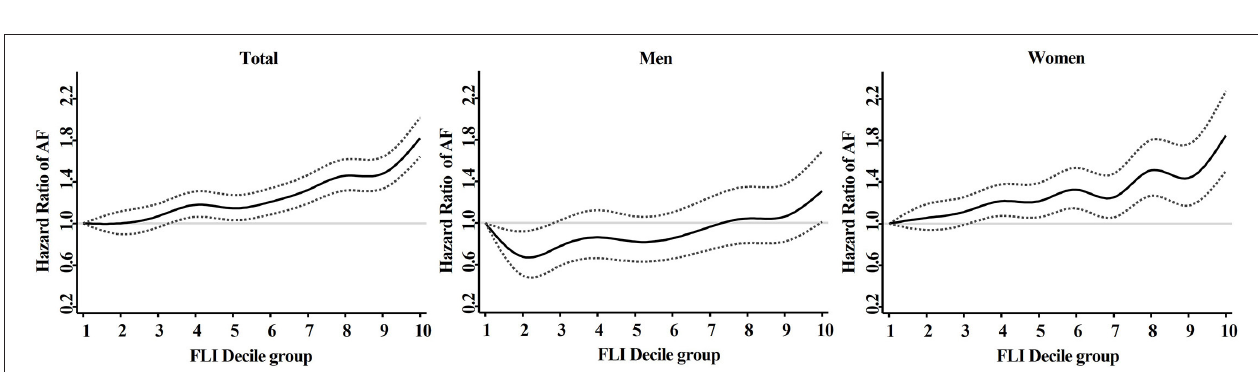
FIGURE 4 | Adjusted hazard ratios (95% confidence interval) of AF in different fatty liver index decile group. Model 3: adjustment of age, sex, hypertension, diabetes mellitus, dyslipidemia, heart failure, prior ischemic stroke, prior myocardial infarction, chronic obstructive pulmonary disease, chronic kidney disease, sleep apnea, hyperthyroidism, smoking, alcohol consumption, and low income. AF, atrial fibrillation; FLI, fatty liver index.